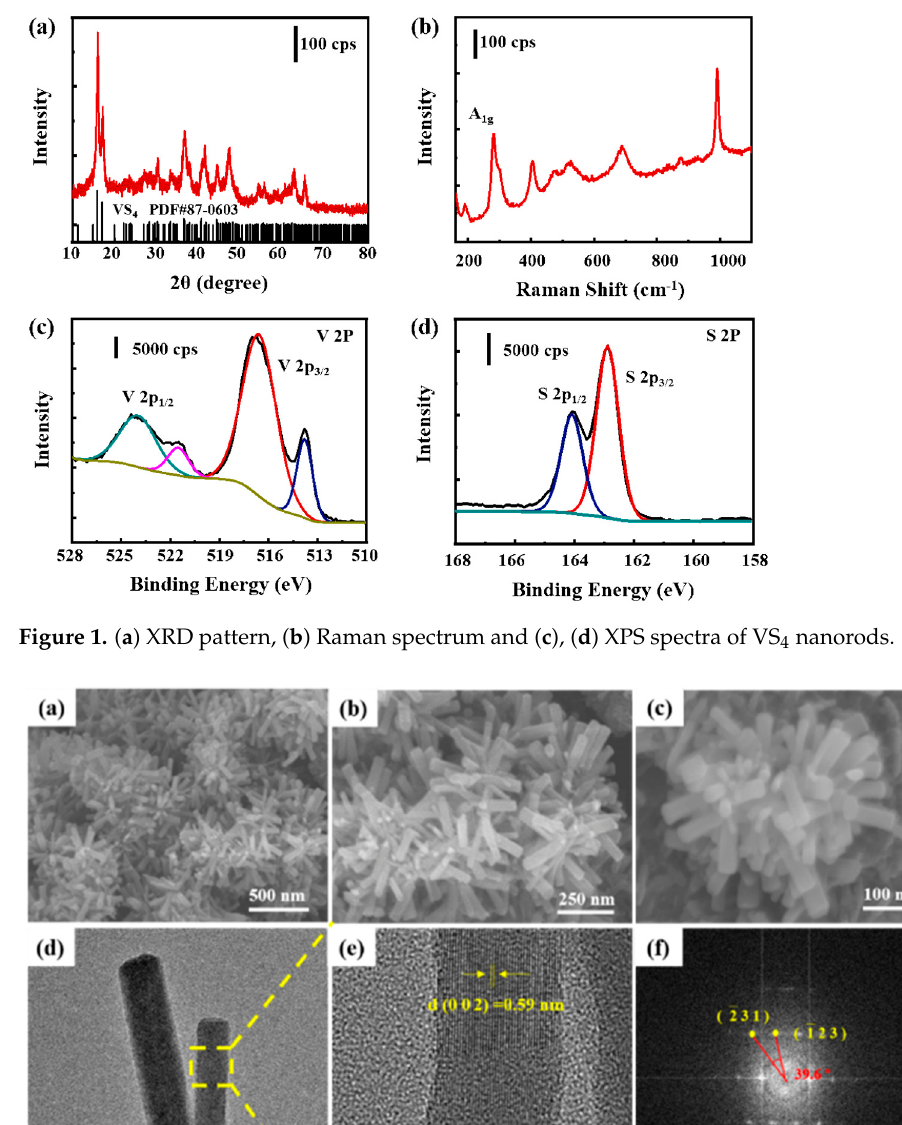
Figure 1. ( a ) XRD pattern, ( b ) Raman spectrum and ( c ), ( d ) XPS spectra of VS 4 nanorods.